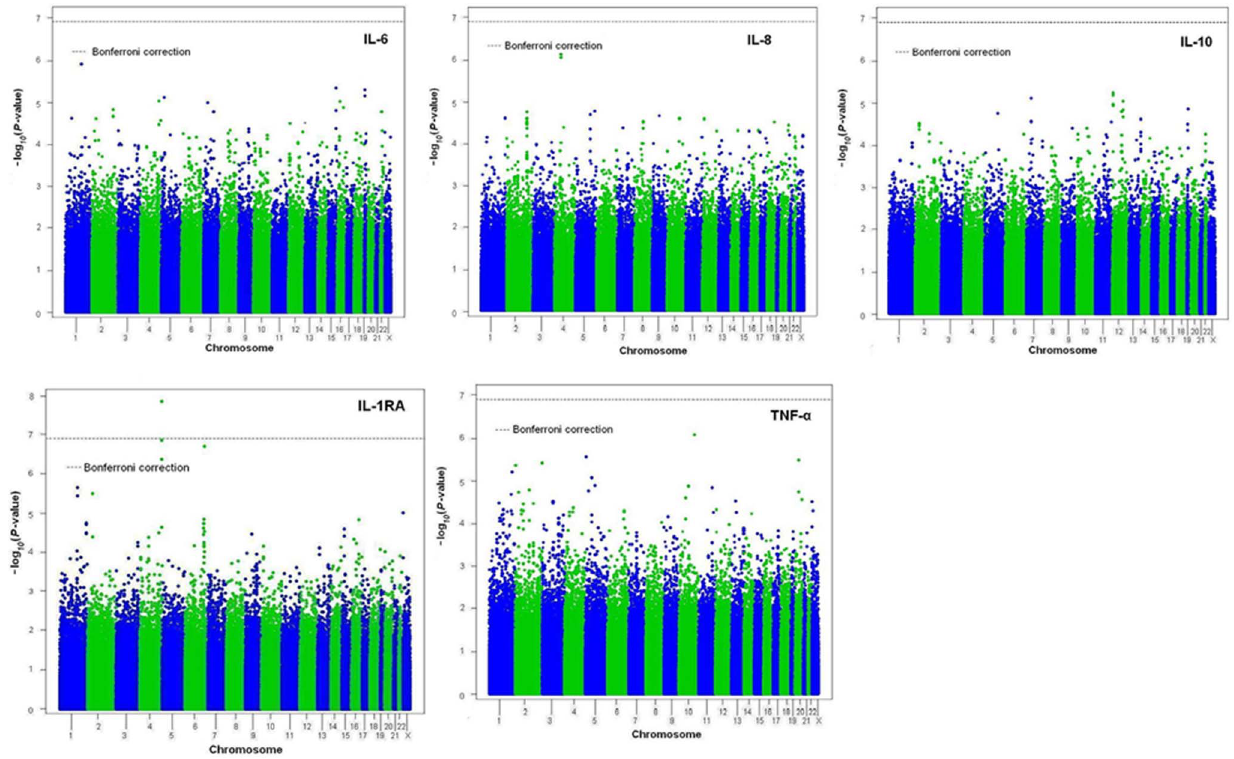
Figure 2. Manhattan plots showing P -values of association of each of the SNPs in the analysis with LPS stimulated plasma cytokine levels. SNPs are plotted on the X-axis to their position on each chromosome against cytokine levels on the Y-axis (shown as –log 10 P -value).